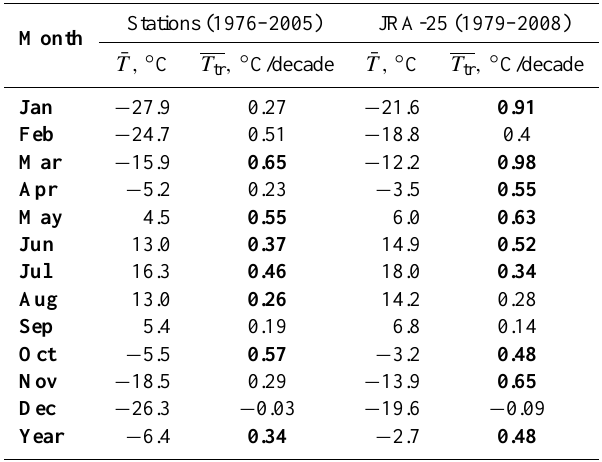
Table 1. Annual averaged temperature values and trends, calculated for the period of 1979-2008 over ATR for observational and reanalysis data. Statistically significant values are in